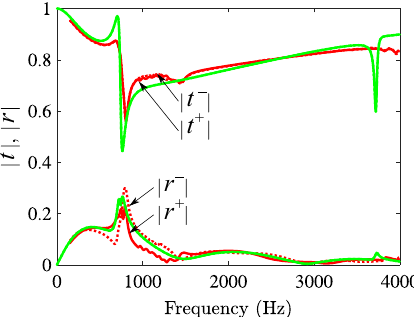
Figure 11. Transmission and re fl ection coef fi cients of the liner sample as a function of the frequency, without fl ow. The experimental results (red curves) are compared to the results provided by the multimodal method (green curves). For the latter, the boundary condition in the lined section is given by the bi-articulated plate